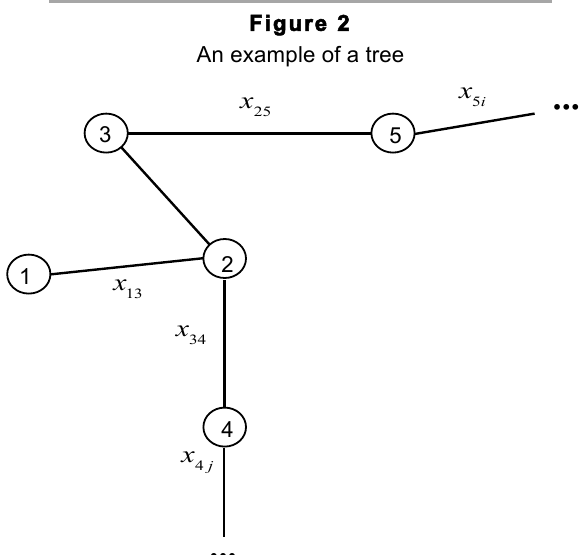
An example of a